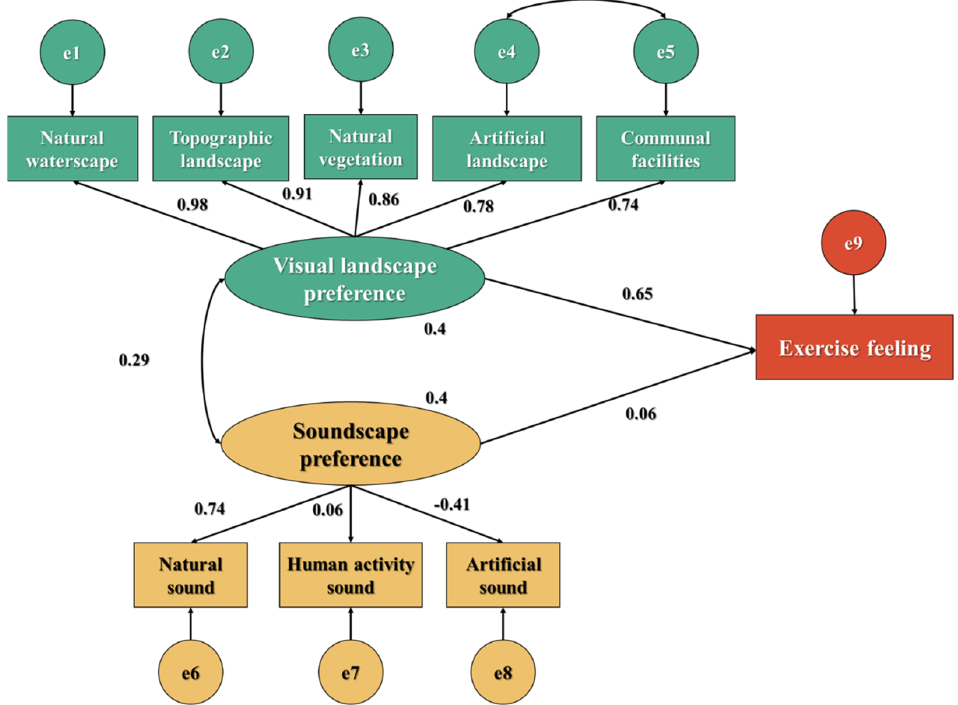
Figure 12. Structural equation model of audio-visual preferences and exercise feelings.